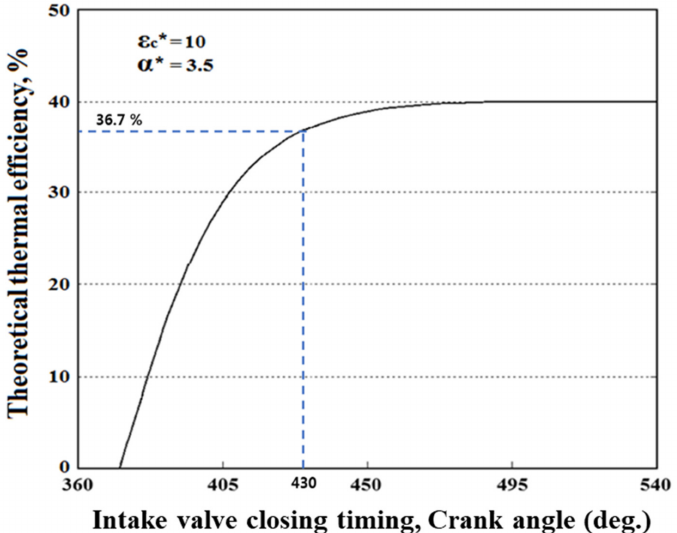
Figure 3. Theoretical thermal efficiency of Otto–Miller cycle according to the intake valve closing